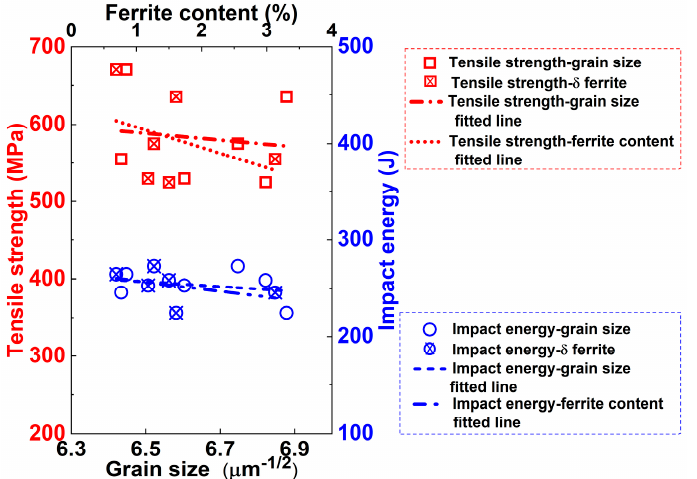
Figure 16. Linear regression of the relationship between tensile strength, impact energy and grain size, and ferrite content.